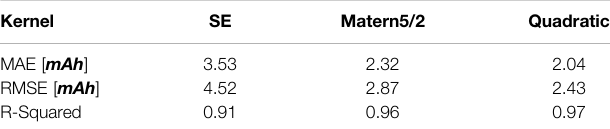
Frontiers in Energy Research |